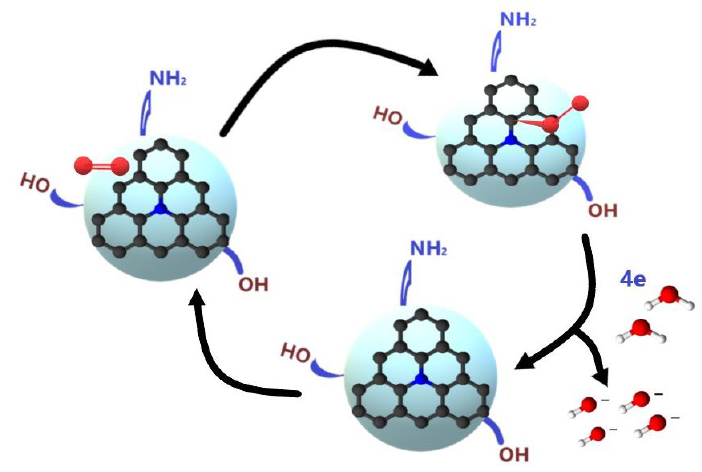
Figure 8. Schematic representation of the ORR on carbon quantum dots.